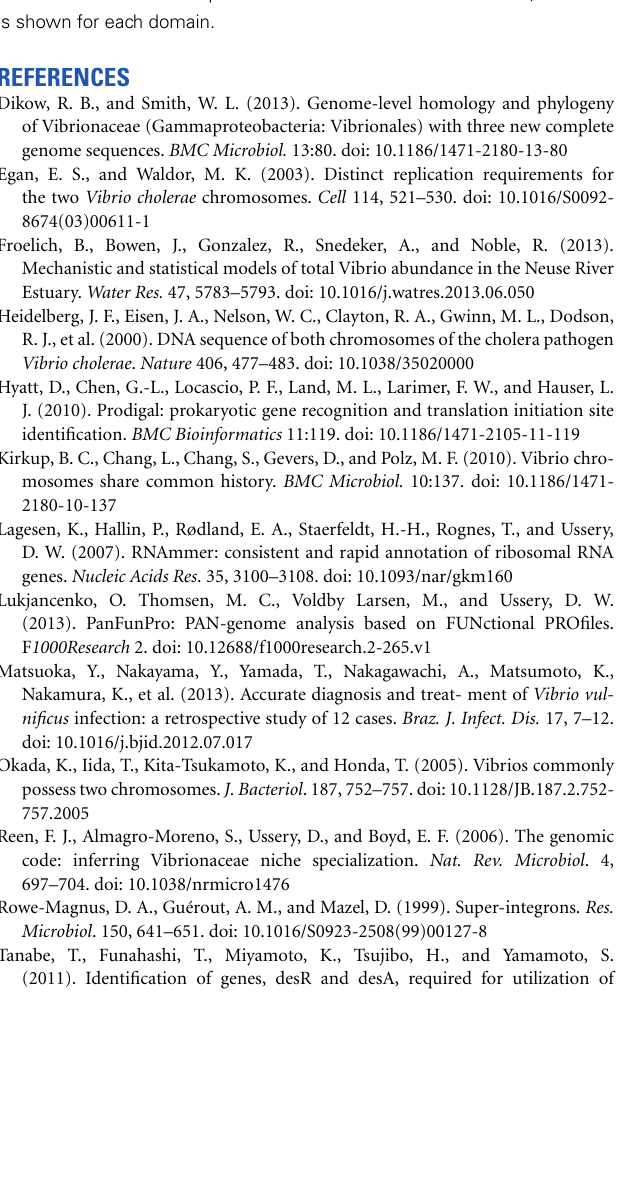
Table S1 | List of Sequence Read Archive (SRA) genomes used in the study. Table S2 | Conserved functional profiles within genomes of set_18. Whether profile consists of more than 1 domain, function is shown for each domain. Table S3 | Profiles, specific for V. cholerae species., in chromosome I and chromosome II. Whether profile consists of more than 1 domain, function is shown for each